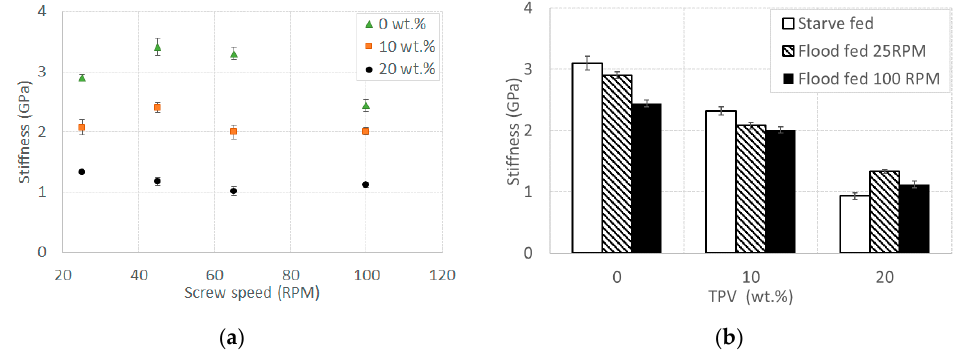
Figure 4. Tensile stiffness ( a ) vs. screw speed for all materials in a flood fed condition at different screw speeds and ( b ) vs. TPV content in a starve fed condition at 100 RPM, flood fed condition at 25 RPM, and flood fed condition at 100 RPM. Error bars indicate the standard deviation.